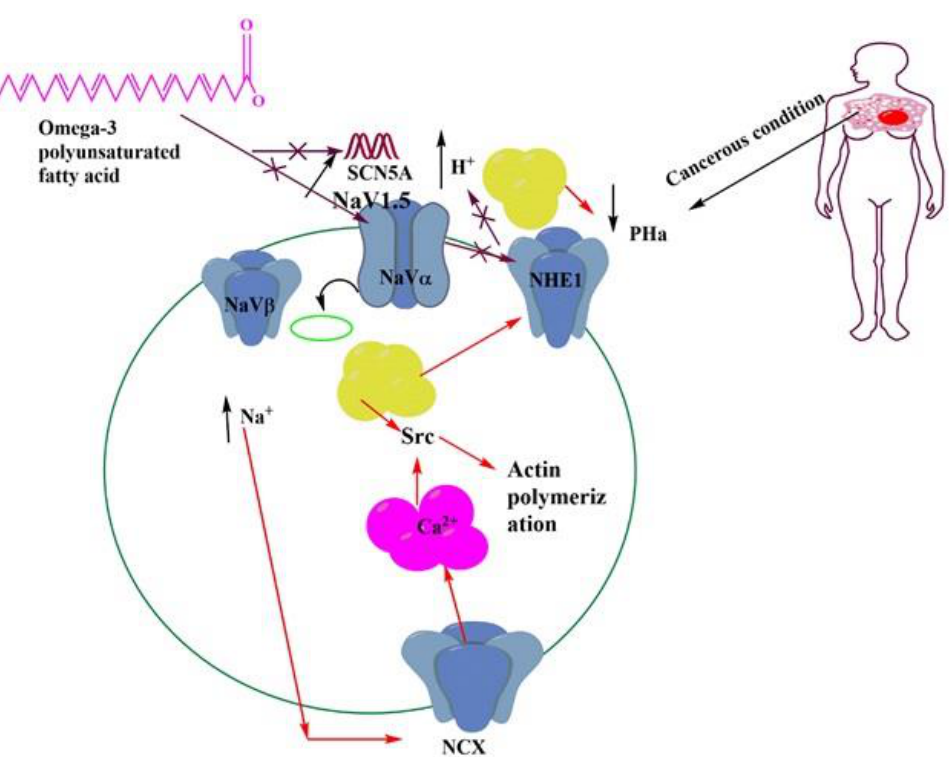
Figure 5. Omega-3 PUFAs in the regulation of channel activity and prevention of cancer progression.